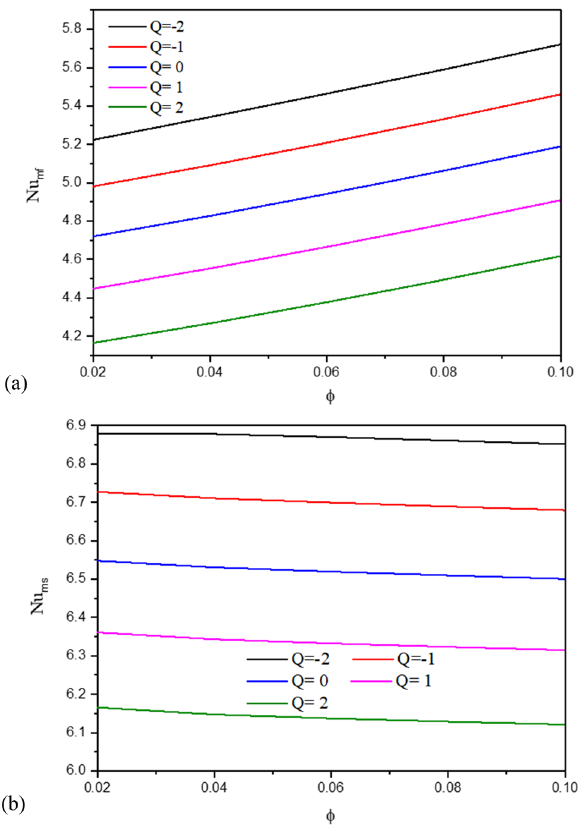
Figure 6. Variation of the Nu mf ( a ) and Nu ms ( b ), along a solid volume fraction φ below the changes on heat generation/absorption coefficient Q for a hybrid nanofluid at φ Cu ε = 0.5, Da = 10 − 3 , Ha = 10, k fs = 1, D = 0.5, k r = 1, H ∗ =